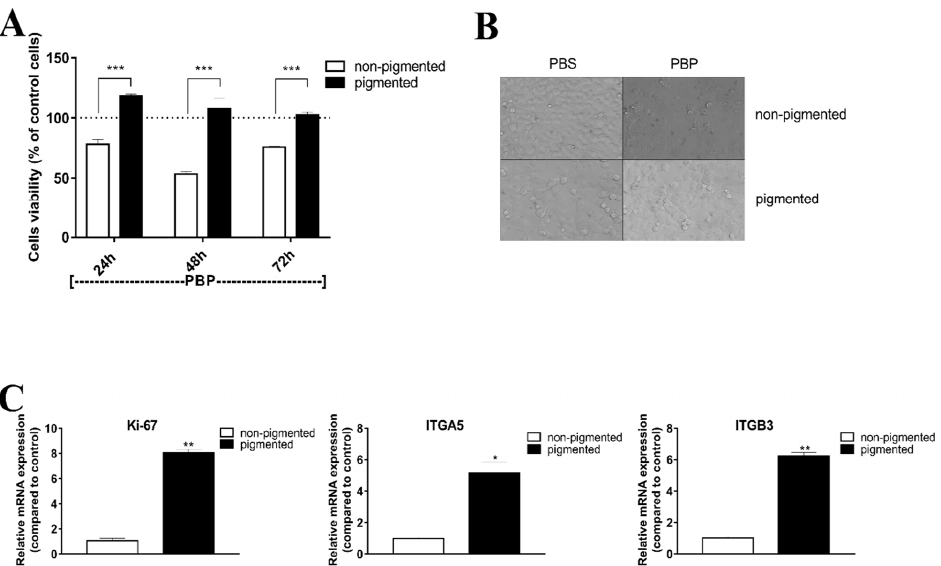
Figure 1. Pigmented melanoma cells are resistant to Coriolus versicolor (CV)-induced cytotoxic effect and express higher mRNA levels of proliferation marker and integrins compared to amelanotic cells. ( A ) The viability of pigmented and non-pigmented melanoma cells treated with CV extract at a concentration of 200 µ g/mL. Data are reported as means ± SEM of three independent experiments, with six wells in each experiment. Asterisks indicate significant differences between non-pigmented and pigmented cells (*** p < 0.001). ( B ) Non-pigmented and pigmented melanoma cells treated with CV extract or PBS (control) for 72 h; 2D images were acquired using Olympus inverted microscope and analyzed using Olympus cellSens Dimension software (20 µ m scale, 40 × magnification). ( C ) mRNA expression levels of Ki-67, ITGA5, and ITGB3 in non-pigmented and pigmented melanoma cells determined by quantitative real-time PCR. Asterisks indicate significant differences between non-pigmented and pigmented cells (* p < 0.05, ** p < 0.01). Abbreviations: PBS—phosphate-buffered saline; CV— Coriolus versicolor